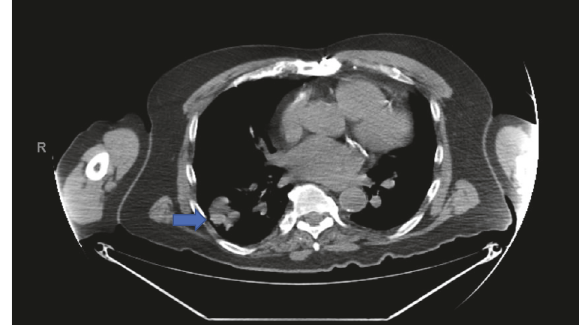
Figure 3: PET scan. Arrow: moderate to intensely increased metabolicactivityintherightlowerlobemass(maxSUV8.4initially increasing to 15.5 on delayed images), without evidence of other focal